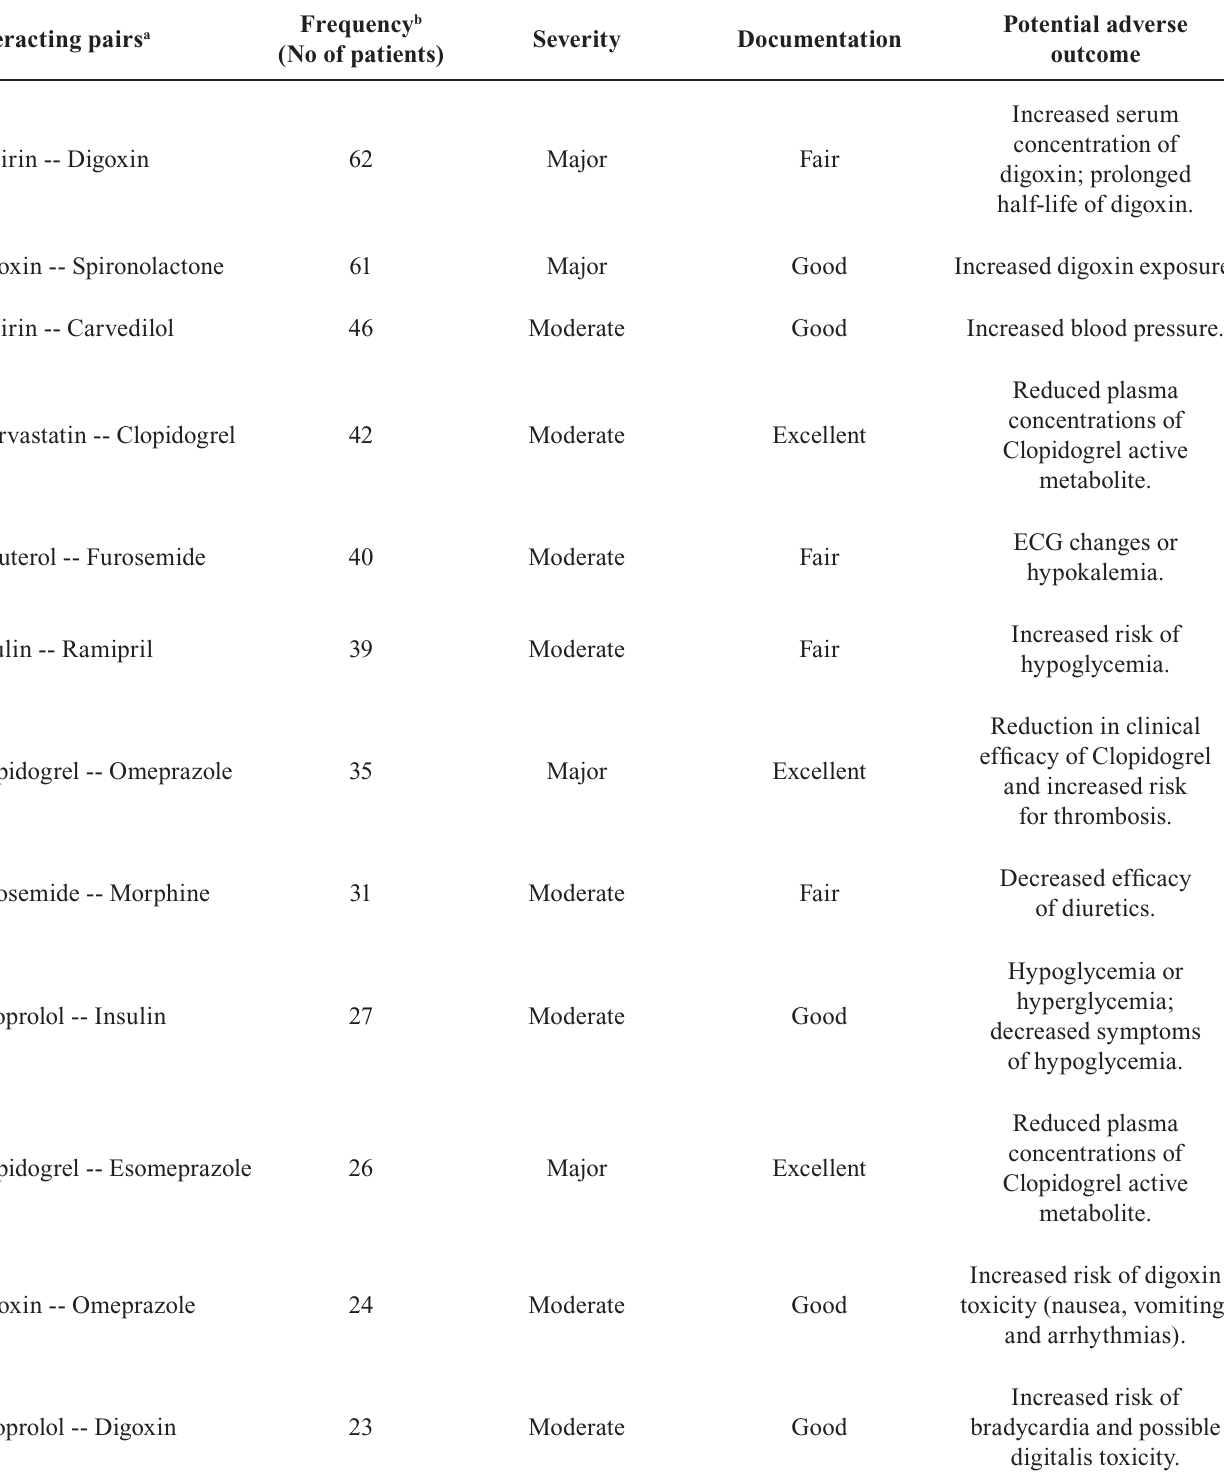
Interacting pairs